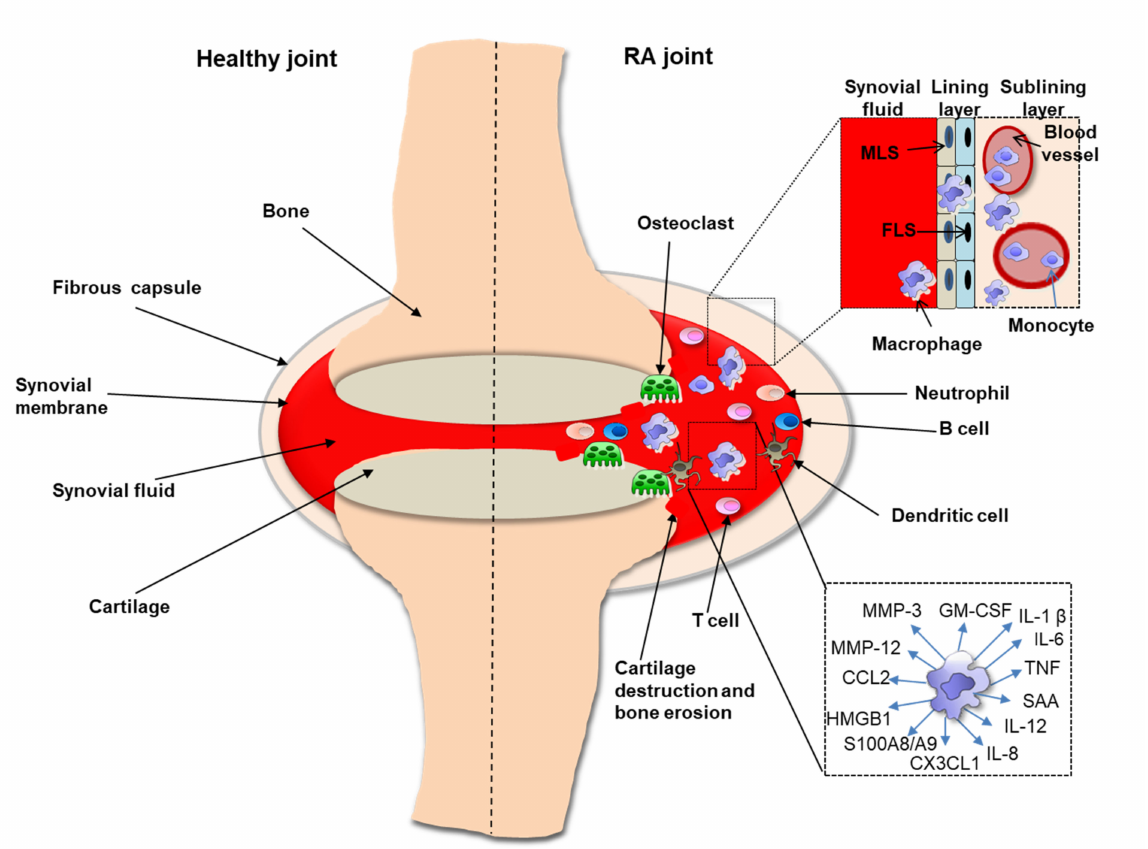
Figure 2. Schematic representation of differences between the RA joint (right) and a healthy joint (left). Mono- cytes/macrophages are the main producers of the pro-inflammatory cytokines that cause arthritis, cartilage destruction and bone loss in the RA joint. Involved in arthritis are also neutrophils, B cells, T cells, dendritic cells and osteoclasts. The synovial membrane is formed by a lining layer and a sublining layer. The lining layer it is made up of MLS (macrophage- like synovial cells) and FLS (fibroblast cells). Non-resident macrophages that arise from monocytes enter the joint from blood